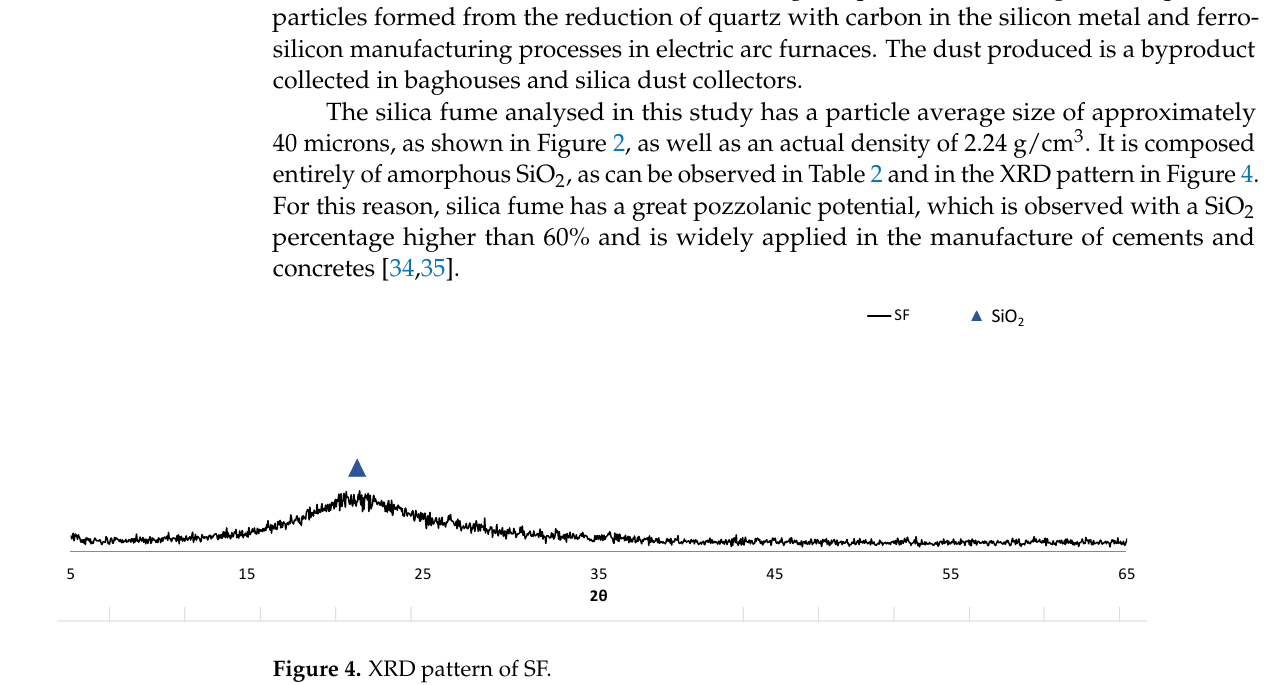
Figure 3. XRD pattern of FA.